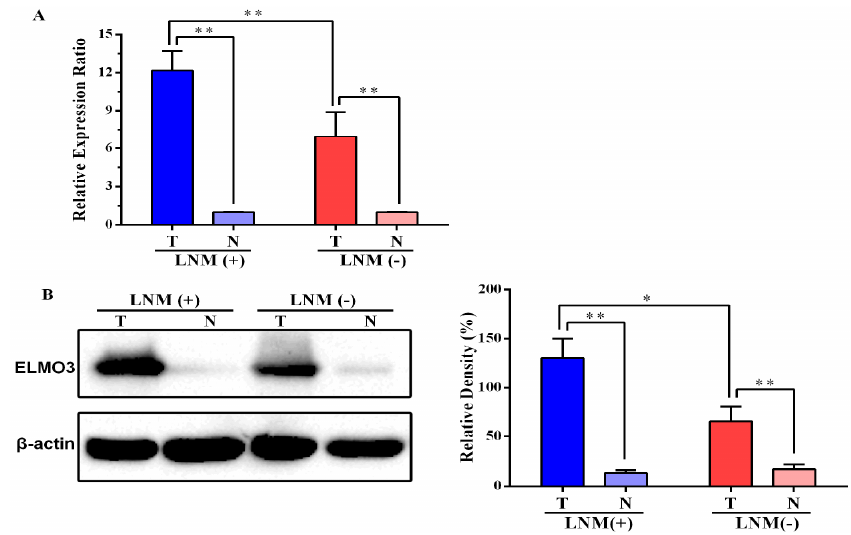
Figure 1. The mRNA and protein levels of ELMO3 in primary colorectal cancer (CRC) tissues and adjacent normal tissues: ( A ) Real-time quantitative PCR was used to detect the ELMO3 mRNA expression level in primary tumors (T) and matched adjacent normal tissues (N) in CRC patients.